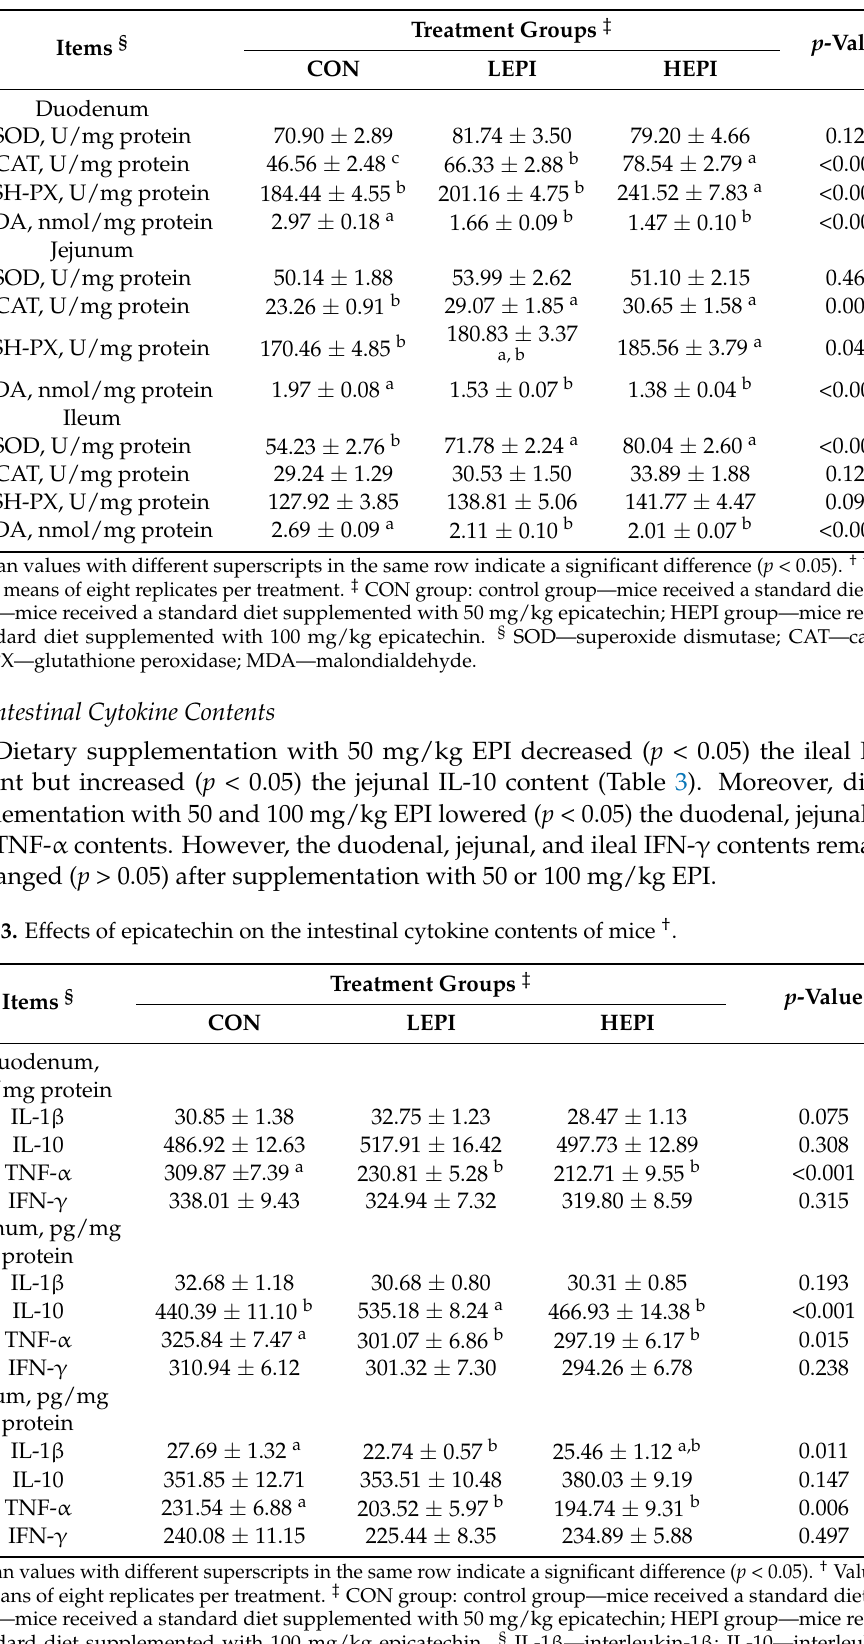
Table 2. Effects of epicatechin on the intestinal antioxidant capacity of mice † .